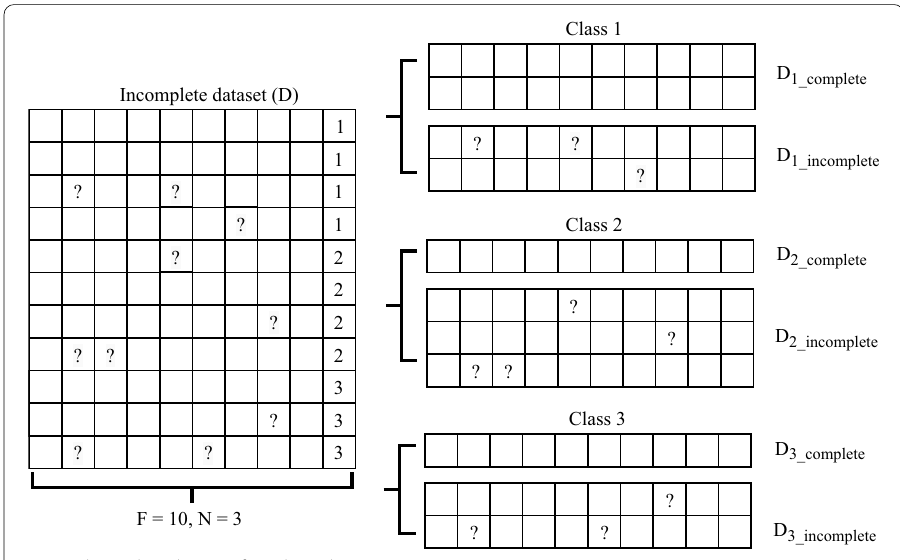
Fig. 2 Three-class datasets for subset